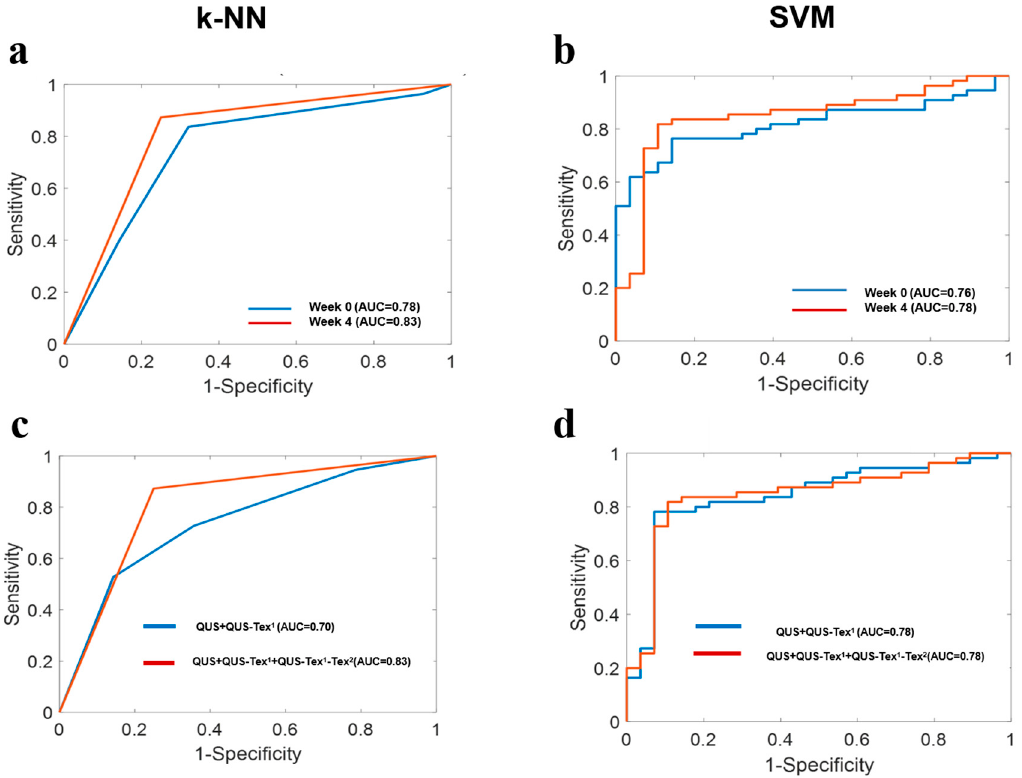
Figure 3. Receiver operating characteristic (ROC) plots showing the estimated area under curve (AUC) values obtained from the two classifiers. ( a , b ) A comparison of the performance by the two classifiers (k-NN and SVM) based on week 0 and week 4 time-points using all features. ( c , d ) The comparison of the performance of QUS + QUS-Tex 1 (without texture derivatives) and QUS + QUS-Tex 1 + QUS-Tex 1 -Tex 2 (with texture derivatives) data set by k-NN and SVM models at week 4.